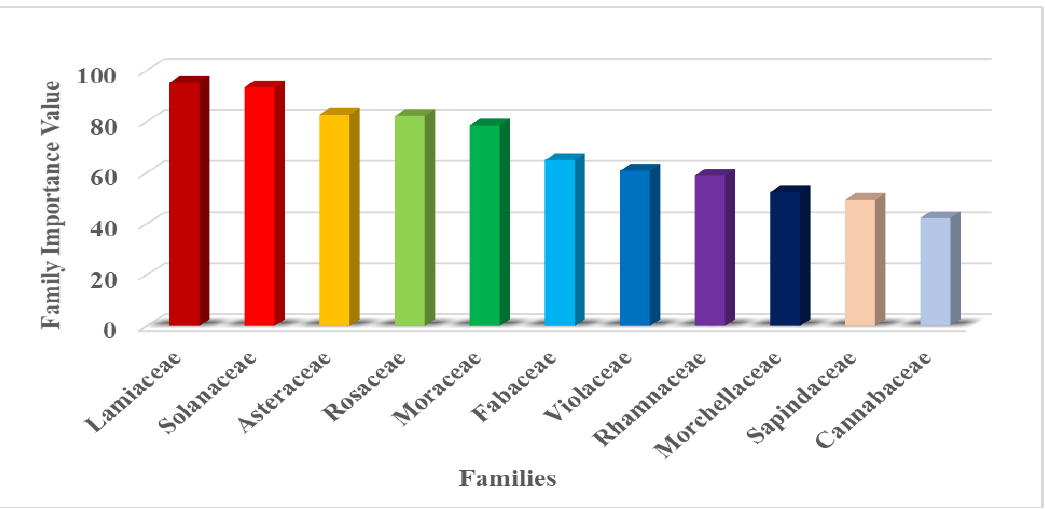
Figure 4. Family Importance Values. Table 5. Family wise distribution of medicinal plants and fungi in the study area.